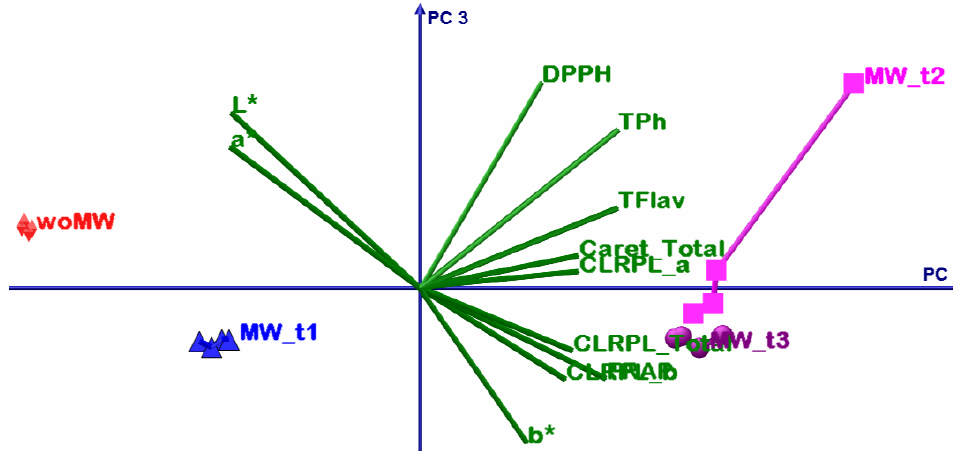
Figure 7. PCA biplot with PC1 (81.04%) and PC3 (3.35%) principal axes.